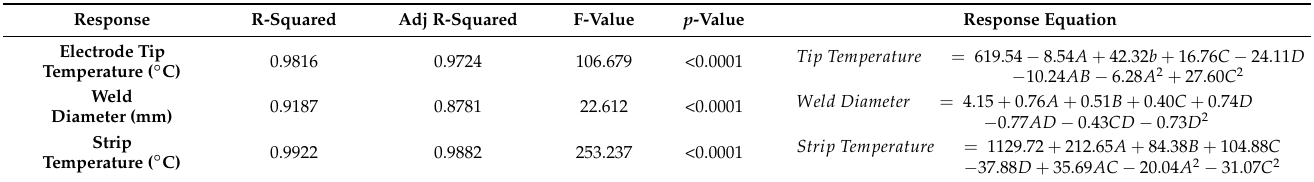
Table 4. Regression models of the three responses.